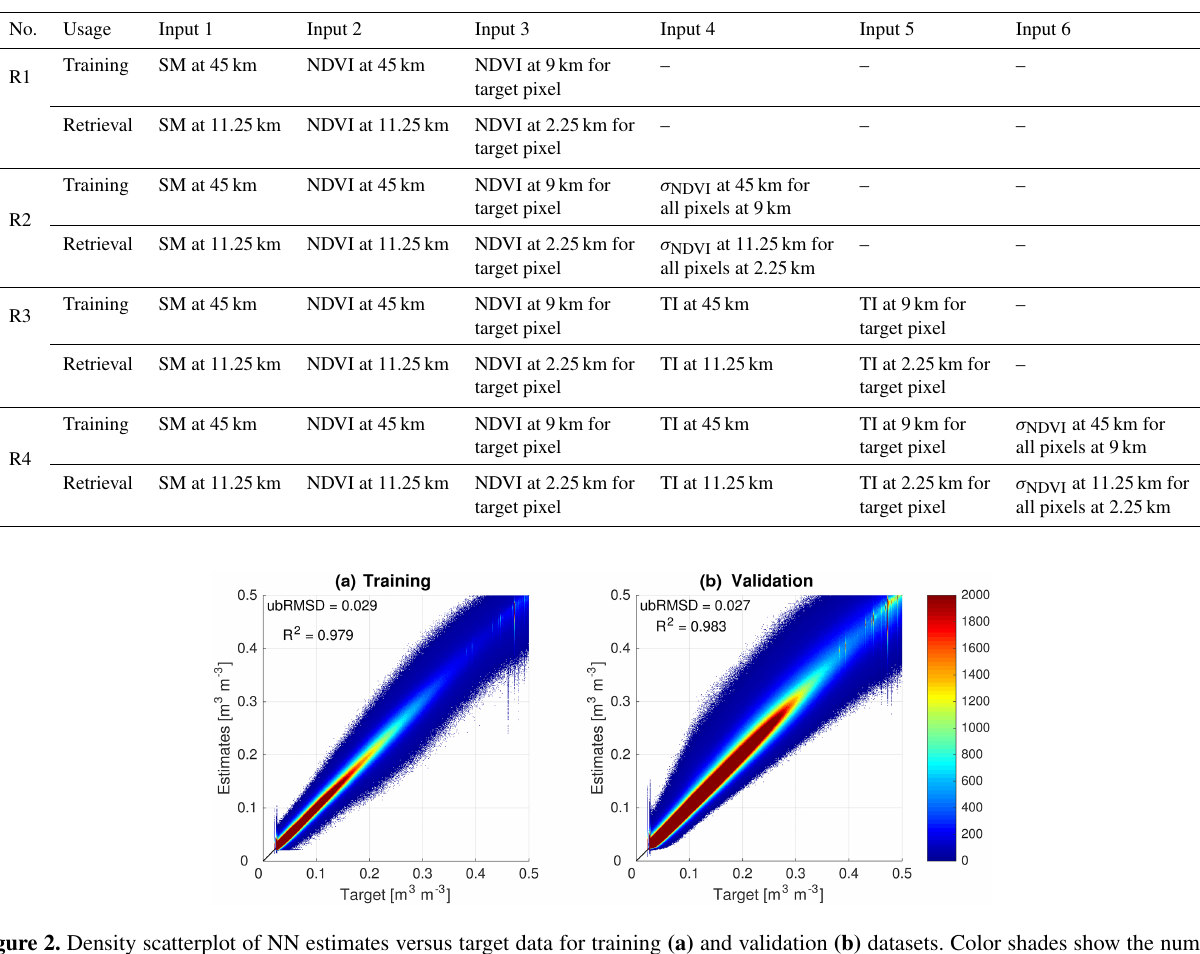
Table 1. Inputs used in each of the downscaling schemes. SM denotes soil moisture.